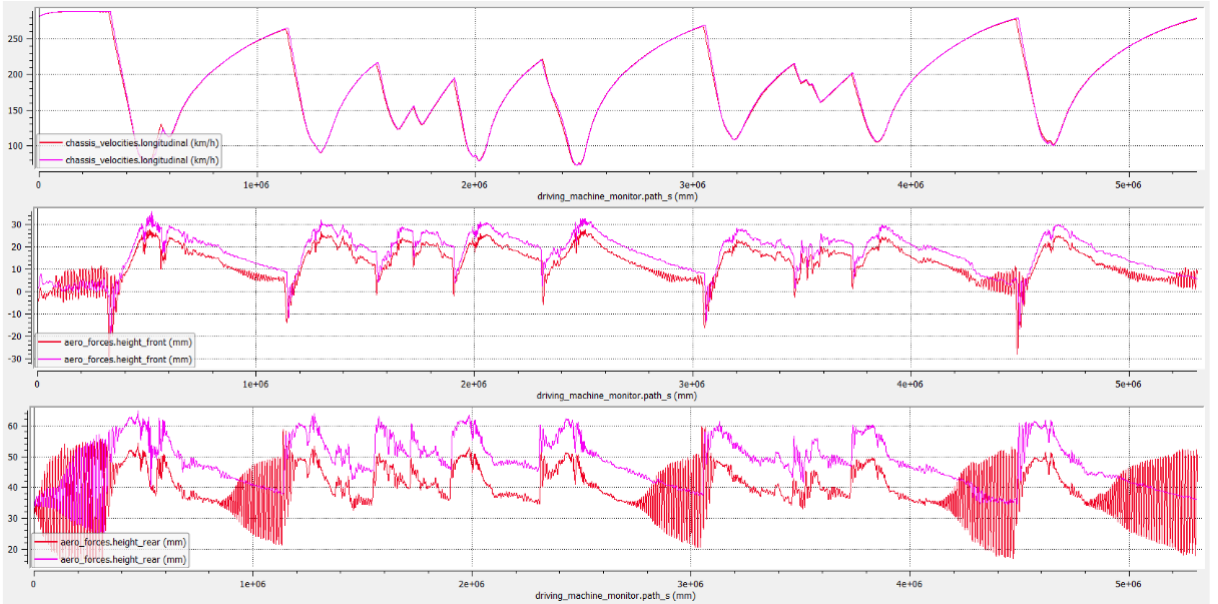
Figure 36. Setup #2 (baseline with porpoising induced by means of the decay functions, red) vs. Setup #3 (FRHS +5 mm, RRHS +10 mm, purple). By raising the ride heights in the correct proportion front to rear porpoising can be reduced without damaging performance too much. Top plot is the speed profile vs. lap distance, mid and bottom plots are the front and rear ride heights.